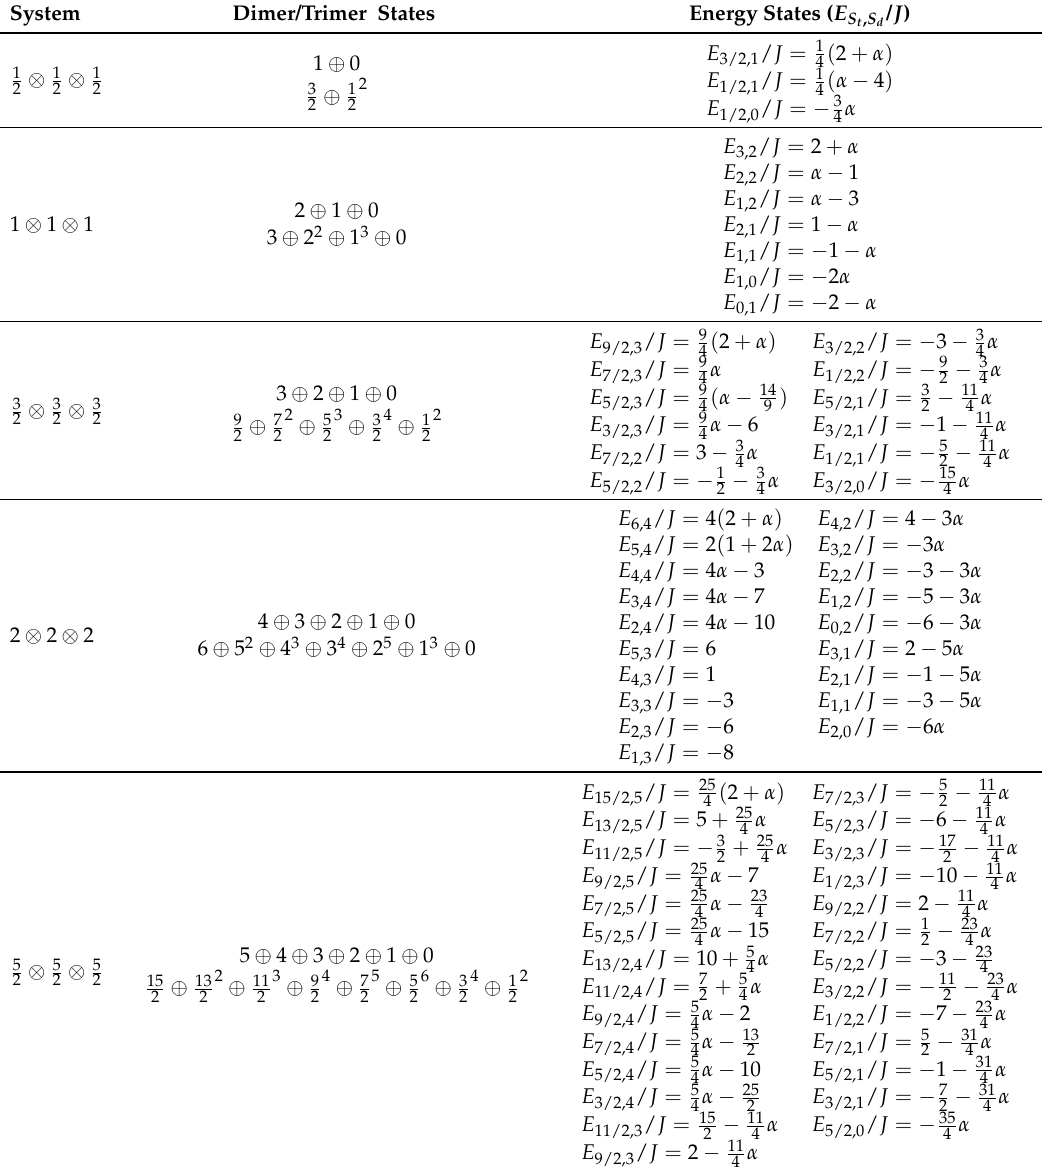
Table 1. Spin decomposition and energy levels for the quantum spin trimers.